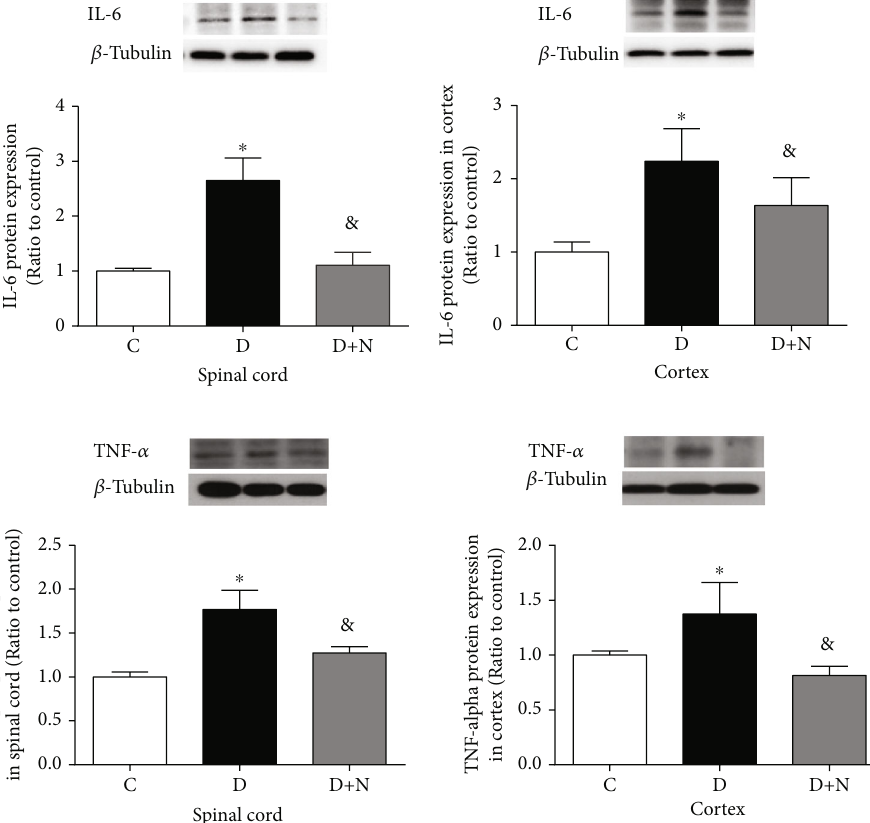
Figure 4: E ff ect of three weeks of NAC treatment on change in expression of IL-6 and TNF- α in the spinal cord and prefrontal cortex of diabetic rats measured by western blotting analysis. All results are presented as means ± SD , n = 6 /group; ∗ P < 0 : 05 (D vs. C), & P < 0 : 05 (D +N vs.